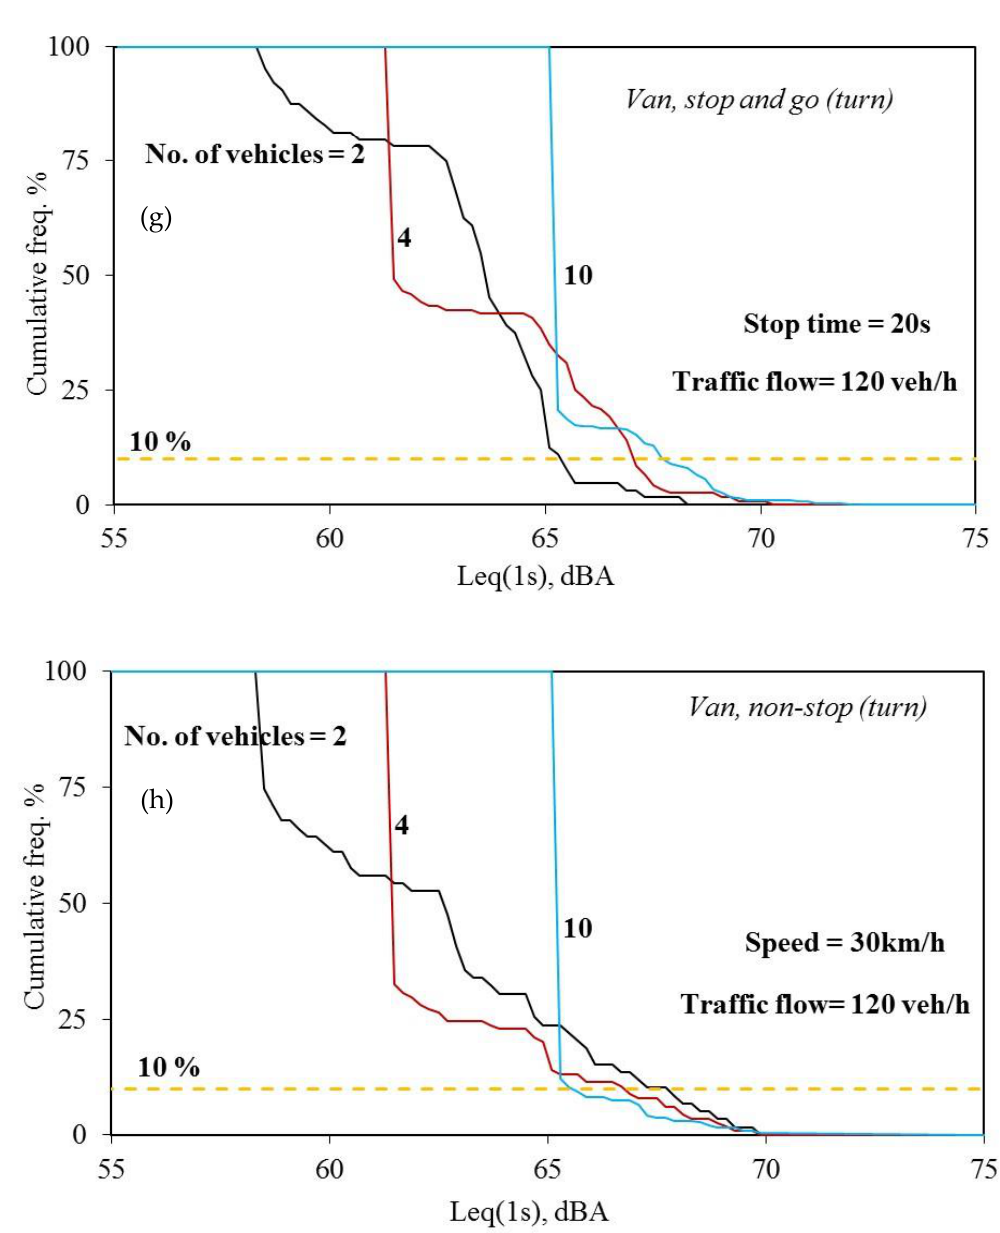
Figure 8. A comparison of average sound pressure levels ( L 10 ) against the number of vans/coaches in “stop and go” and “non-stop” cases. ( a ) Van, stop and go, turn; ( b ) Van, stop and go, straight; ( c ) Coach, stop and go, straight; ( d ) Van, non-stop, turn; ( e ) Van, non-stop, straight; ( f ) Coach, non-stop, straight; ( g ) Cumulative frequency, van, stop and go, turn; ( h ) Cumulative frequency, van, non-stop, turn.